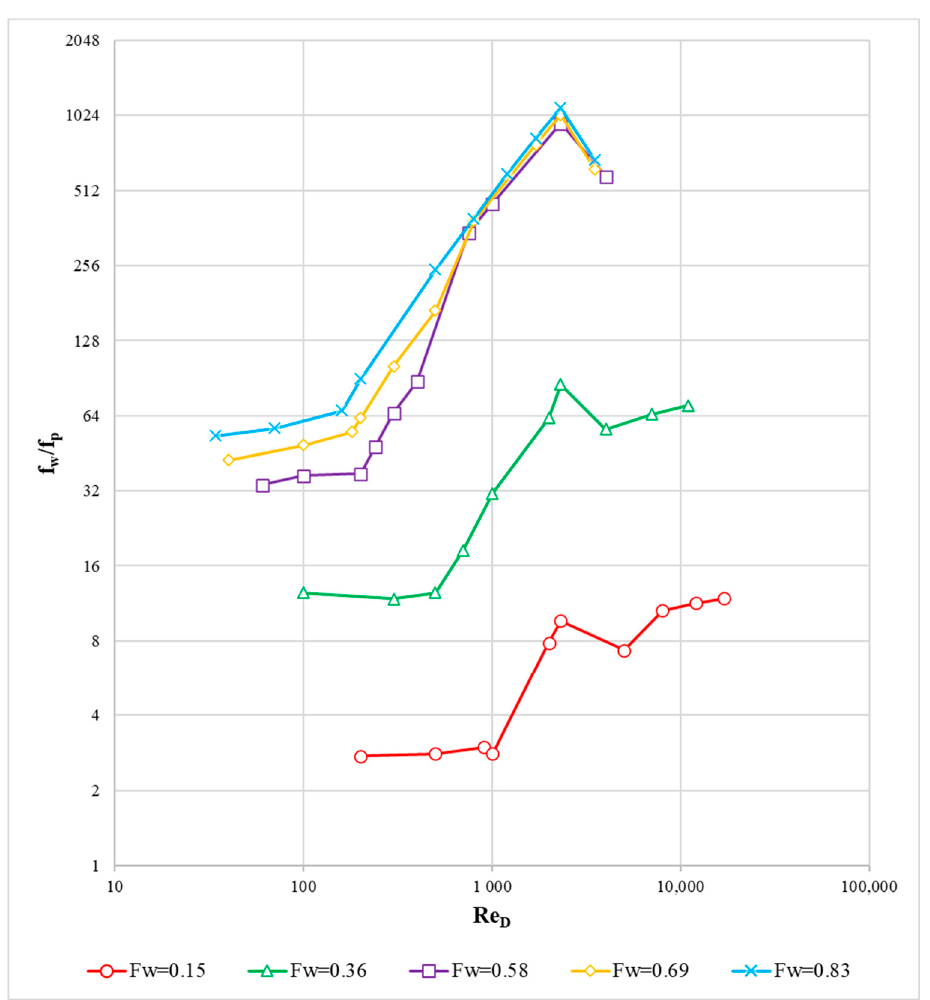
Figure 9. Friction factor increment in wavy-walled